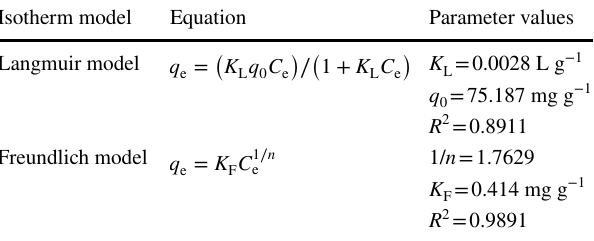
Table 6 Parameter values from fitting the adsorption equilibrium data Isotherm